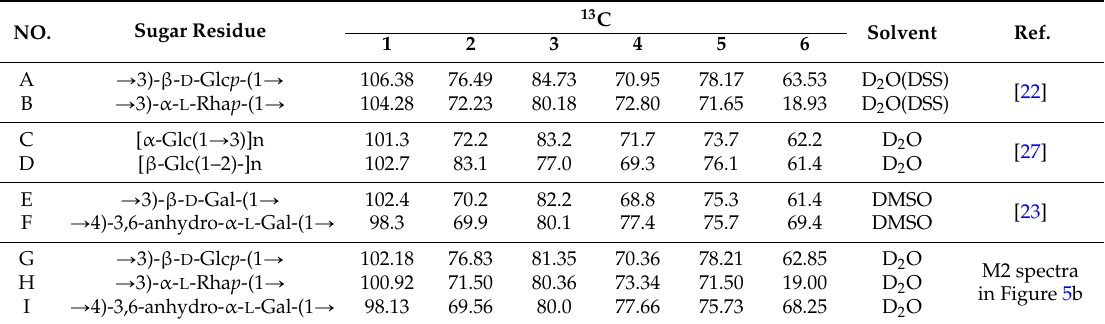
Table 5. Chemical shifts (proton/carbon) of monosaccharide in M2 compared with model-determined